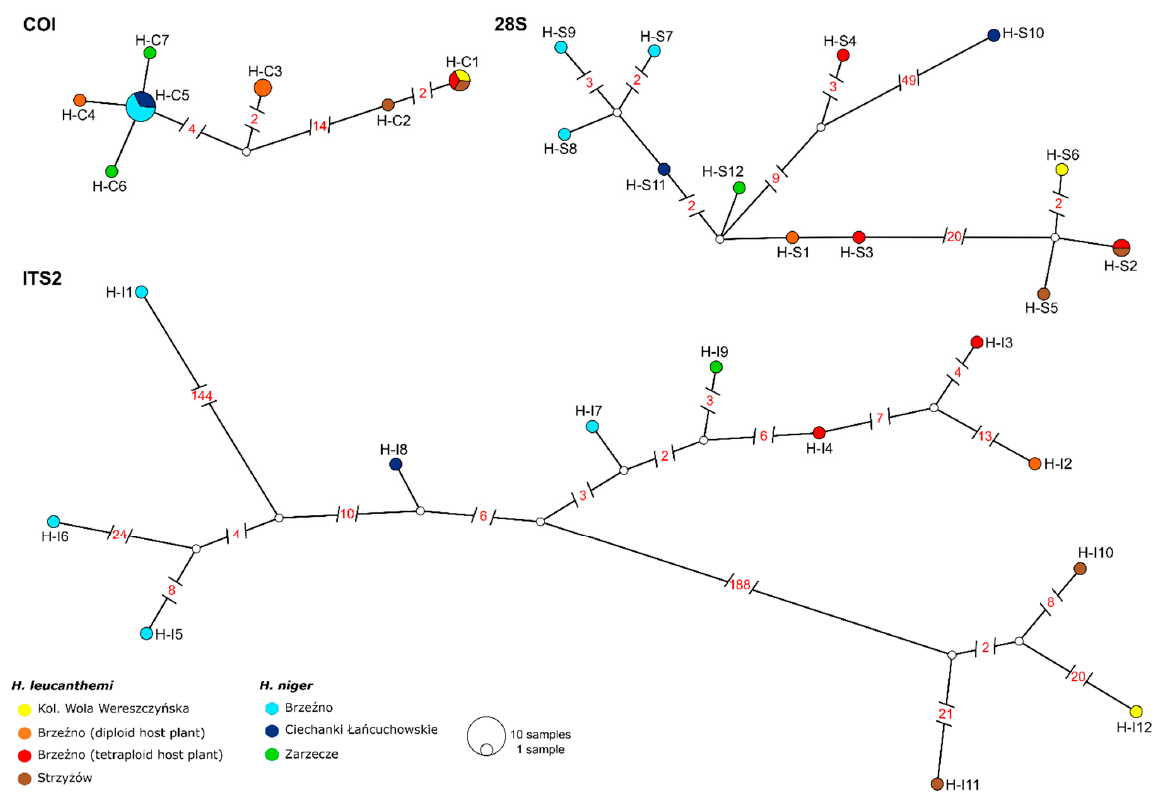
Figure 1. TCS networks resolving relationships among haplotypes identified in tested samples of Haplothrips leucanthemi and H. niger . Colored circles represent unique haplotypes encountered in analyses and lines connecting circles represent base-pair differences between haplotypes (values above 1 are shown). White circles represent intermediate haplotypes that were not encountered in the sampling. Size of the circle represents the frequency of the haplotype.